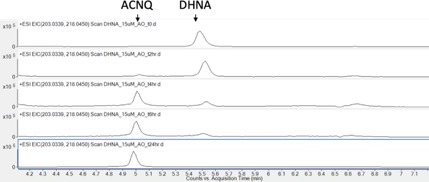
DHNA conversion to ACNQ in ammonium phosphate, pH 8.No DHNA was observed after 24 hr of incubation at room temperature under aerobic conditions.